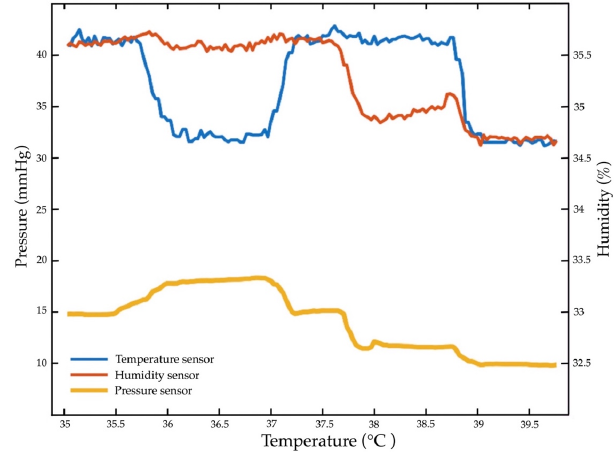
Figure 20. The repeatability test of the pressure, temperature, and humidity sensors.